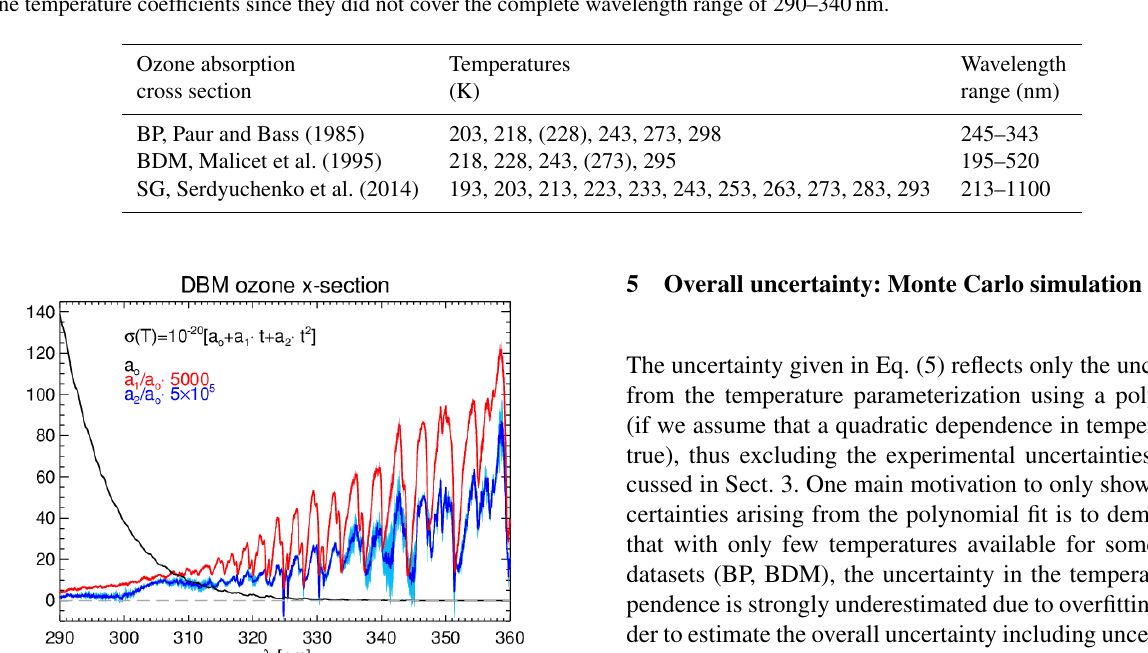
Table 7. Available temperatures for various ozone absorption cross-section data. Temperatures provided in brackets were not used to deter- mine temperature coefficients since they did not cover the complete wavelength range of 290–340nm.